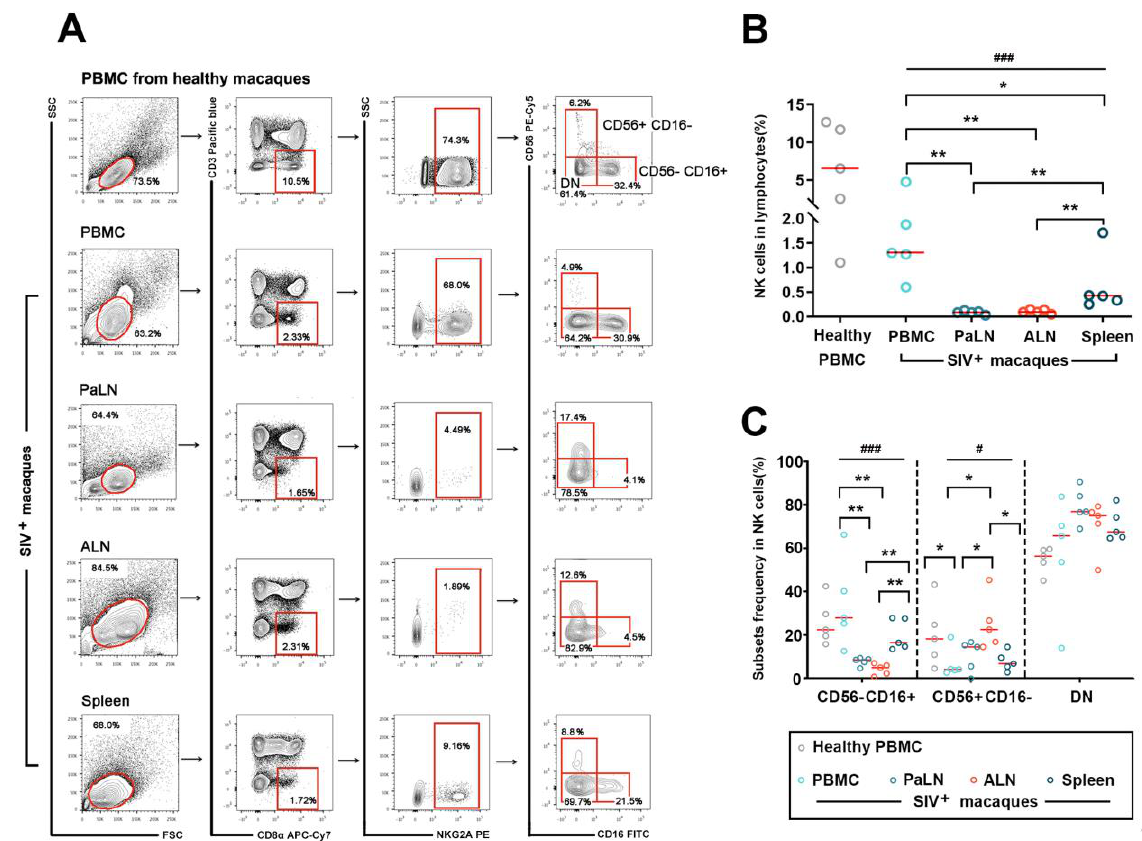
Figure 1. The distribution of simian NK cells and their subsets in peripheral blood and secondary lymphoid organs in SIV-infected macaques. ( A ) Flow cytometric gating defined NK cell subsets (CD3 − CD8 α + NKG2A + ) in PBMCs from healthy macaques ( n = 5) and in single cells of peripheral blood, PaLNs, ALNs, and spleen from SIV-infected macaques ( n = 5). This illustration shows a representative plot of NK cell subsets form a healthy macaque and an infected macaque. ( B ) The frequencies of NK cells in total lymphocytes from different tissues. ( C ) The distributional characteristics of three NK subsets (CD56 − CD16 + , CD56 + CD16 − , and DN, CD56 − CD16 − ). Lines represent median values; little circles in different colors mean five SIV-infected macaques’ percentage levels in different groups. As the data did not obey a normal distribution, after comparing multiple group differ- ences using the Kruskal – Wallis test, the Mann – Whitney U test was performed to compare differ- ences between the two groups. “#” indicate s significant differences using the Kruskal – Wallis test (#,